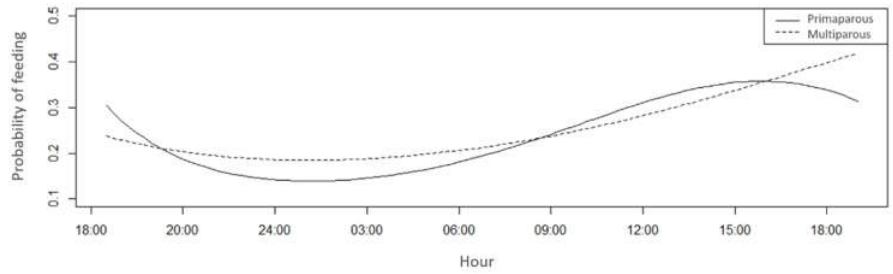
Figure 8. Feeding probability of primiparous (solid line) and multiparous cows (dotted line) in a compost barn.